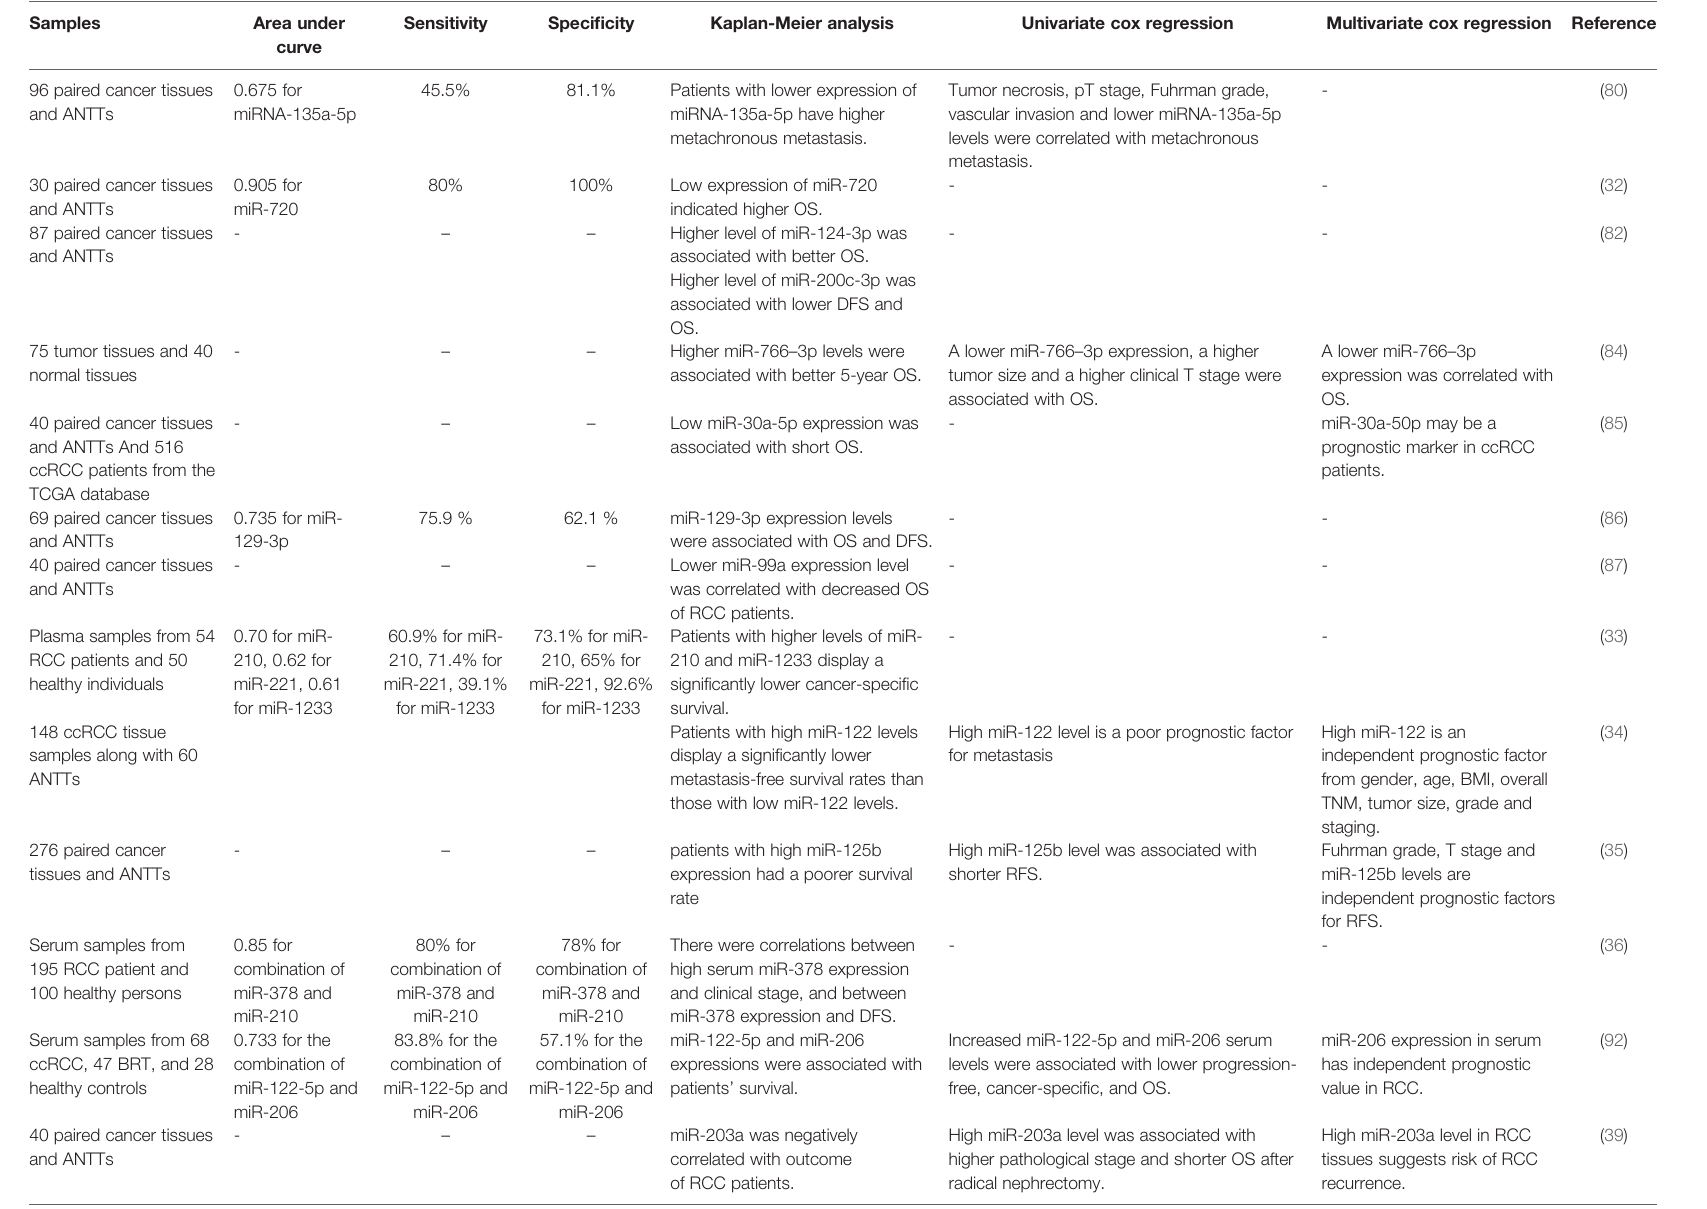
TABLE 3 | Diagnostic/prognostic role of miRNAs in renal